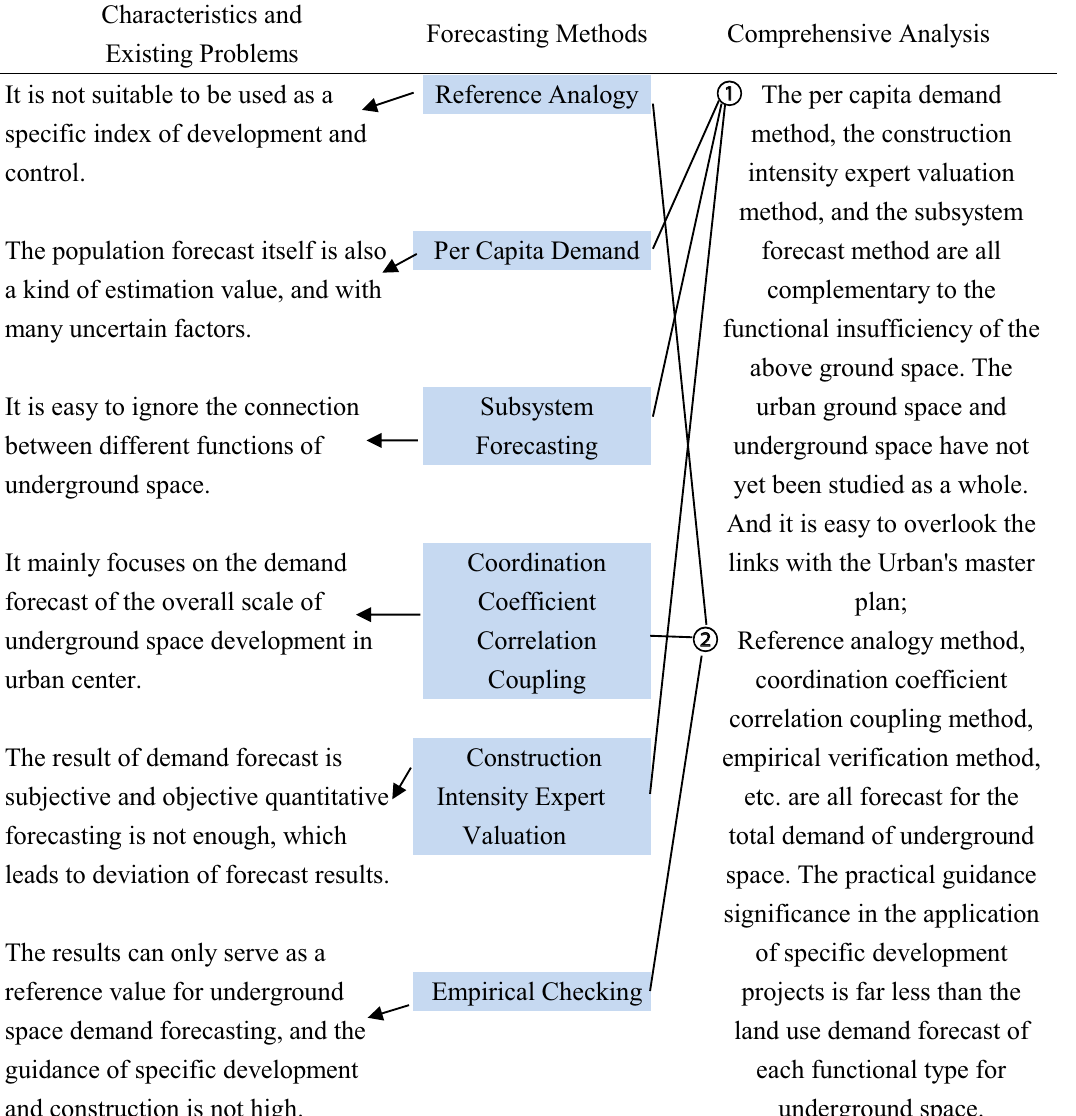
Table 2 Problems and characteristics of forecasting methods Characteristics